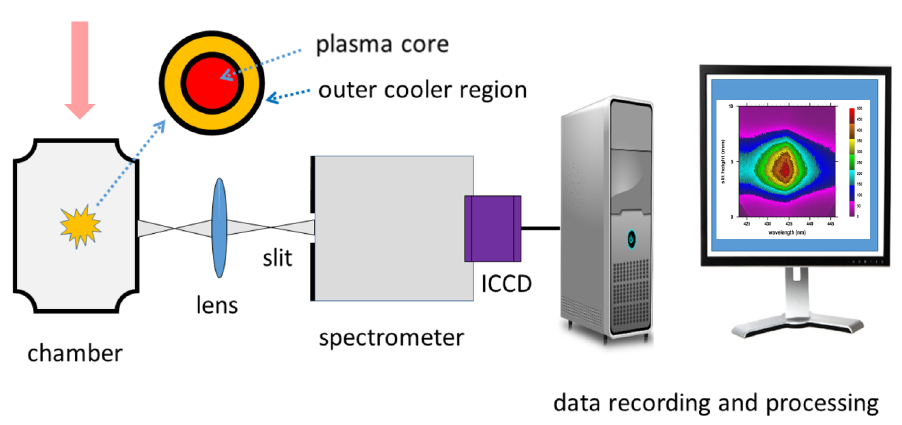
Figure 1. Optical breakdown plasma is generated by focusing the laser beam from the top and parallel to the slit. Time-resolved 1:1 images are recorded with the